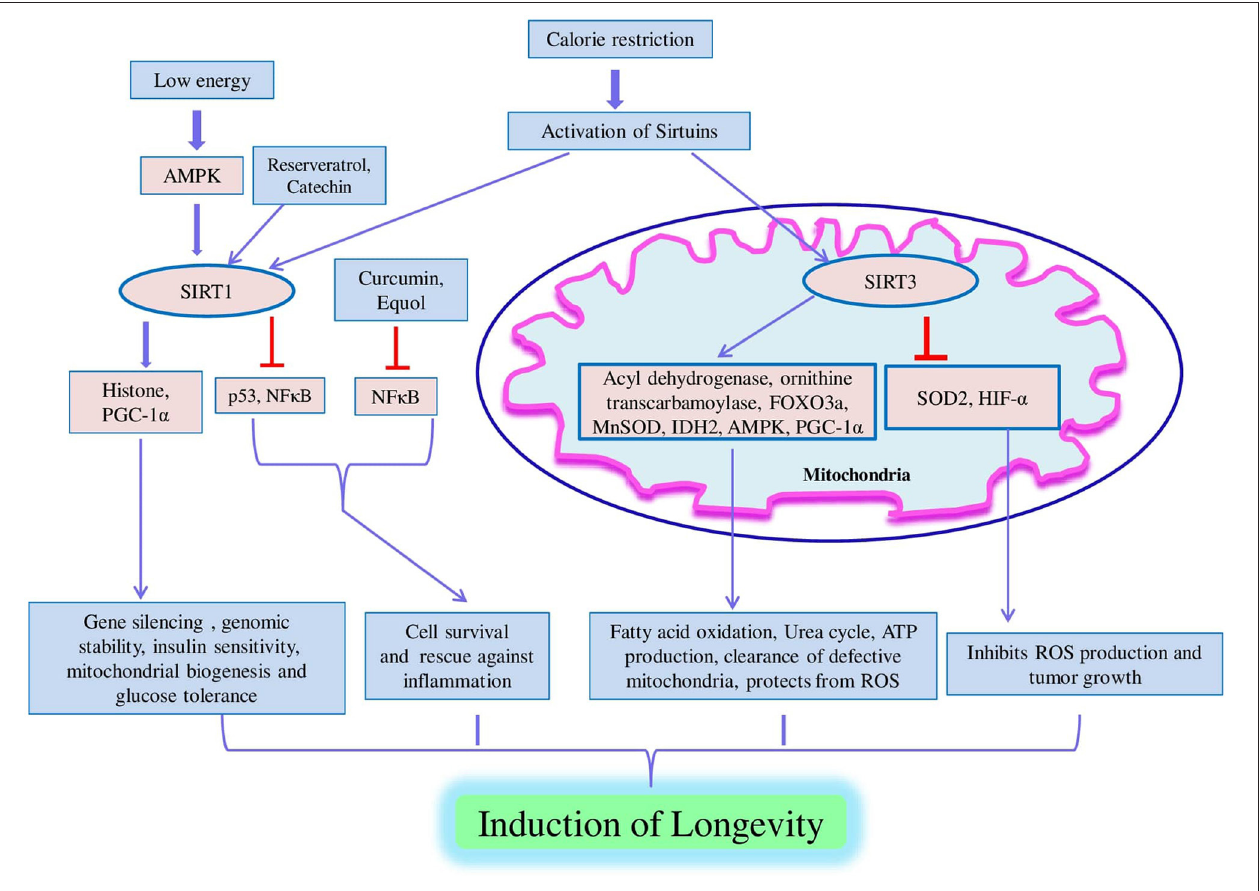
FIGURE 6 | Model of sirtuin pathway. Sirtuin pathway is activated. In response to low energy upon calorie restriction in cells, AMPK is activated which promotes SIRT1-mediated trans -activities. SIRT1 regulates key biological processes such as gene silencing, genomic stability, insulin sensitivity, mitochondrial biogenesis, glucose tolerance, cell survival, and protection against inflammation and mediates longevity via deacetylation of various substrates like histone, PGC1- α , p53, and NF κ B. In response to prolonged calorie restriction, upregulation of SIRT3 occurs in liver and brown adipose tissue which results in the activation of long-chain acyl dehydrogenase and ornithine transcarbamoylase that is associated with β -oxidation of fatty acids and the urea cycle. SIRT3 positively modulates the FOXO3a, MnSOD, isocitrate dehydrogenase 2 (IDH2), AMPK, and PGC-1 α ; promotes ATP production and clearance of defective mitochondria; and protects against ROS. SIRT3 inhibits ROS production and tumor growth via negative regulation of SOD2 and hypoxia-inducing factor-alpha (HIF- α